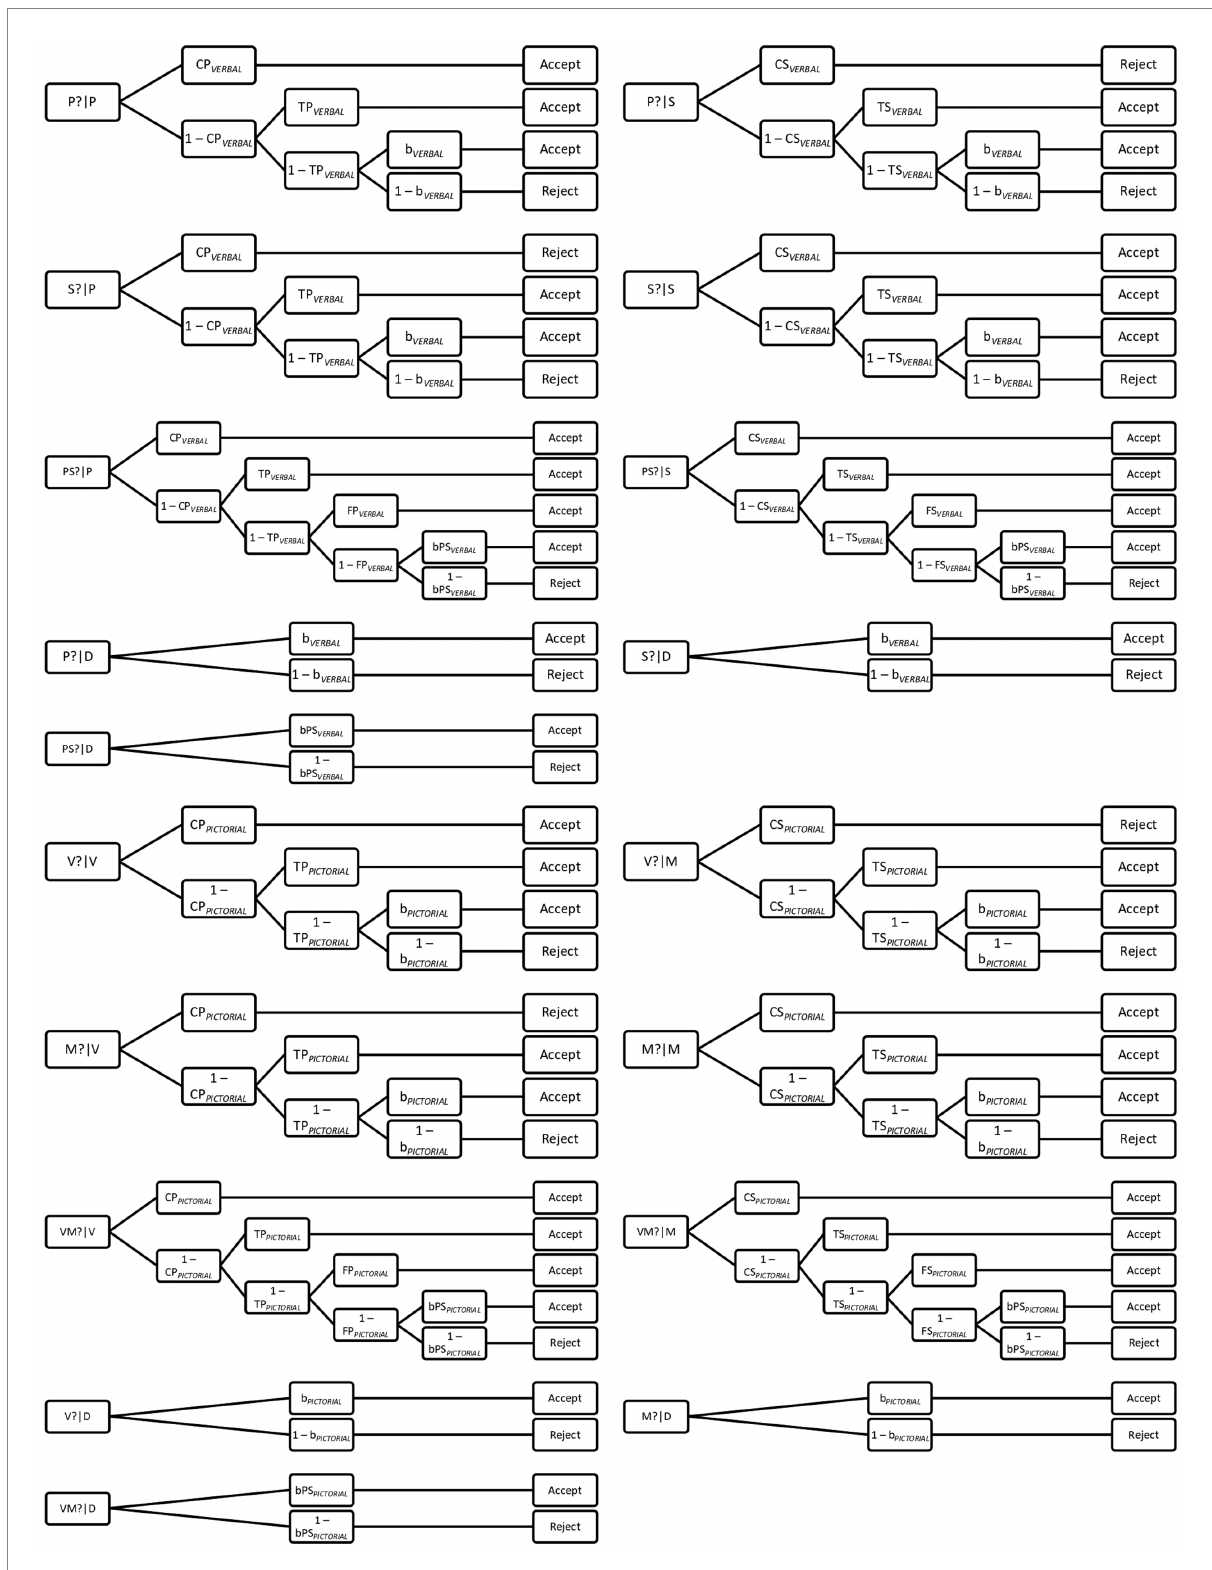
FIGURE 1 Dual recollection multinomial tree model for verbal and pictorial conditions (Brainerd et al., 2015; Nieznański, 2020). P/V—perceptual context for targets in verbal (Phonological)/visual (Visual) conditions; S/M—semantic context for targets in verbal (Semantic)/visual (Meaning) conditions; D— distractor; P?/V?—perceptual probe presented during test in verbal/visual conditions; S?/M?—semantic probe presented during test in verbal/visual conditions; and PS?/VM?—“perceptual or semantic” probe presented during test in verbal/visual